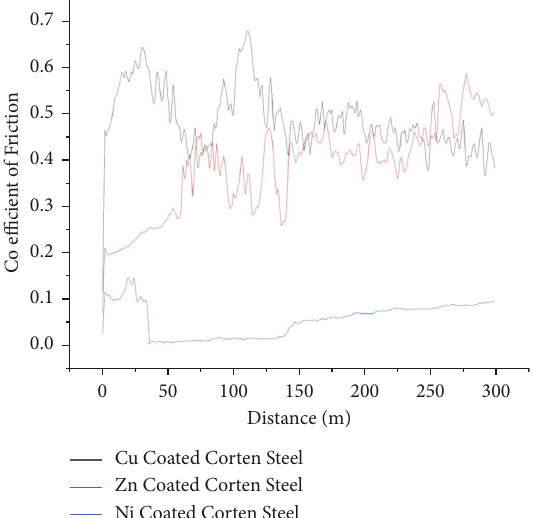
Figure 13: Coefficient of friction of electroplated corten steel.